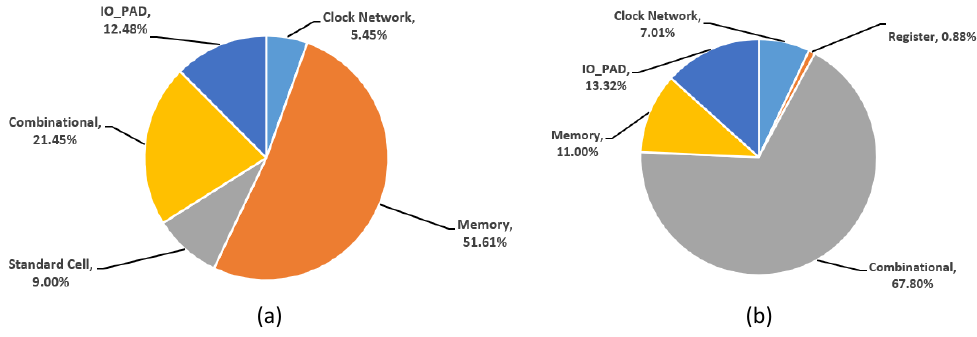
Figure 14. ( a ) Area breakdown. ( b ) Component-wise power